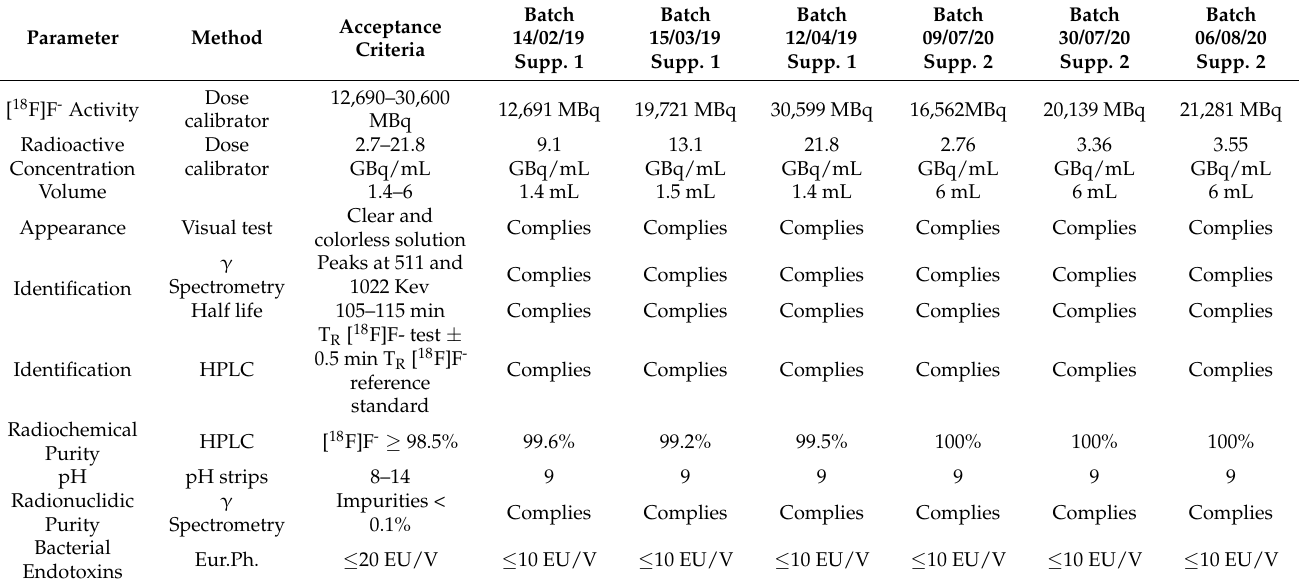
Table 2. Quality control data on [ 18 F]F - batches from different suppliers.